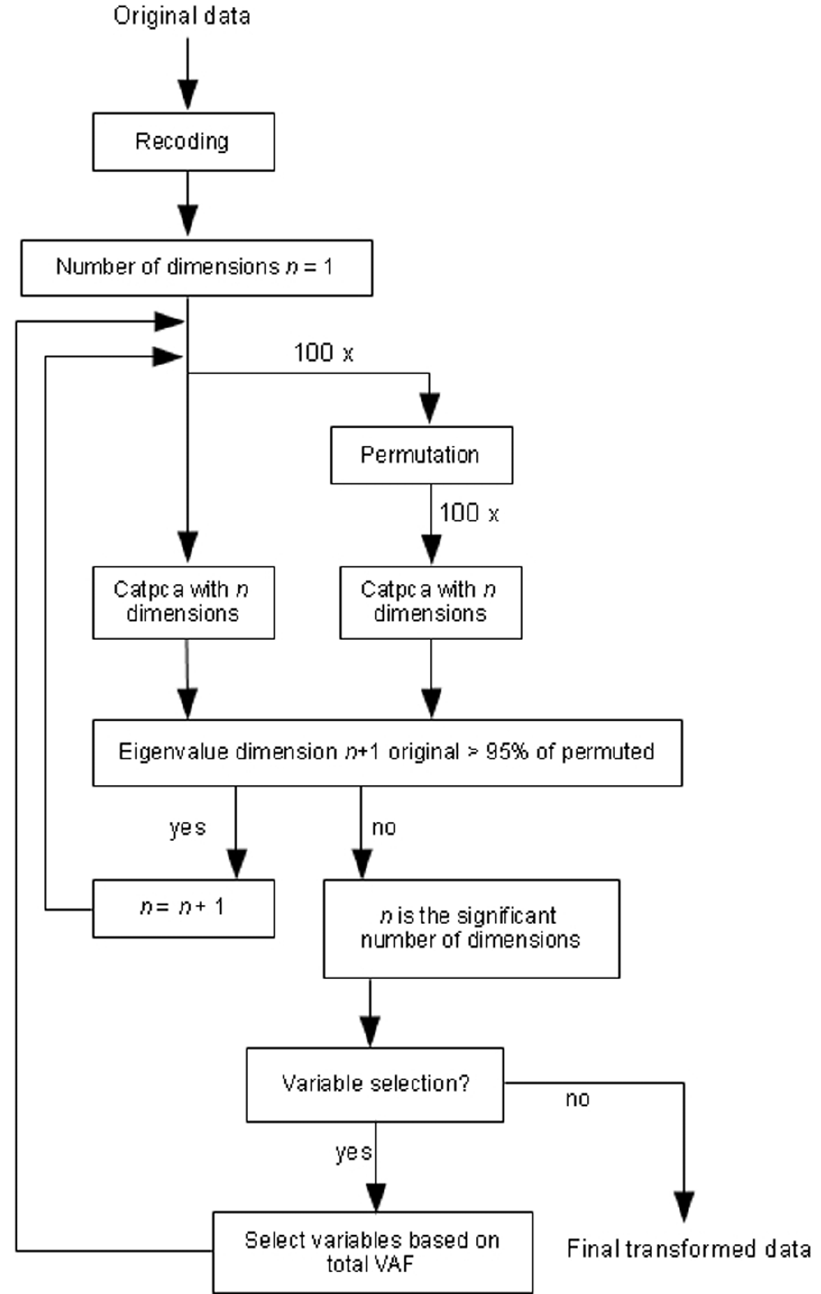
Figure 1. CATPCA data analysis strategy flowchart.